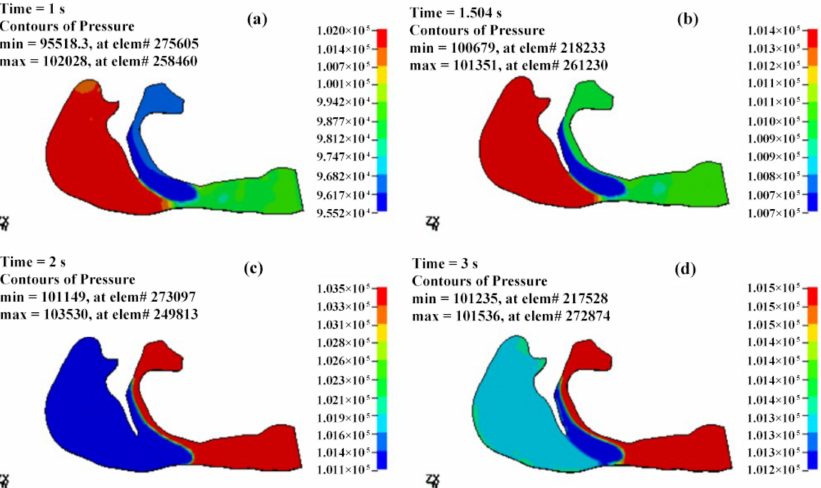
Figure 11. The pressure distributions of the fluid field of the OSAHS patient’s upper airway under the state of apnea (pressure unit in Pa). ( a , b ) The inspiration phase; ( c , d ) the expiration phase.